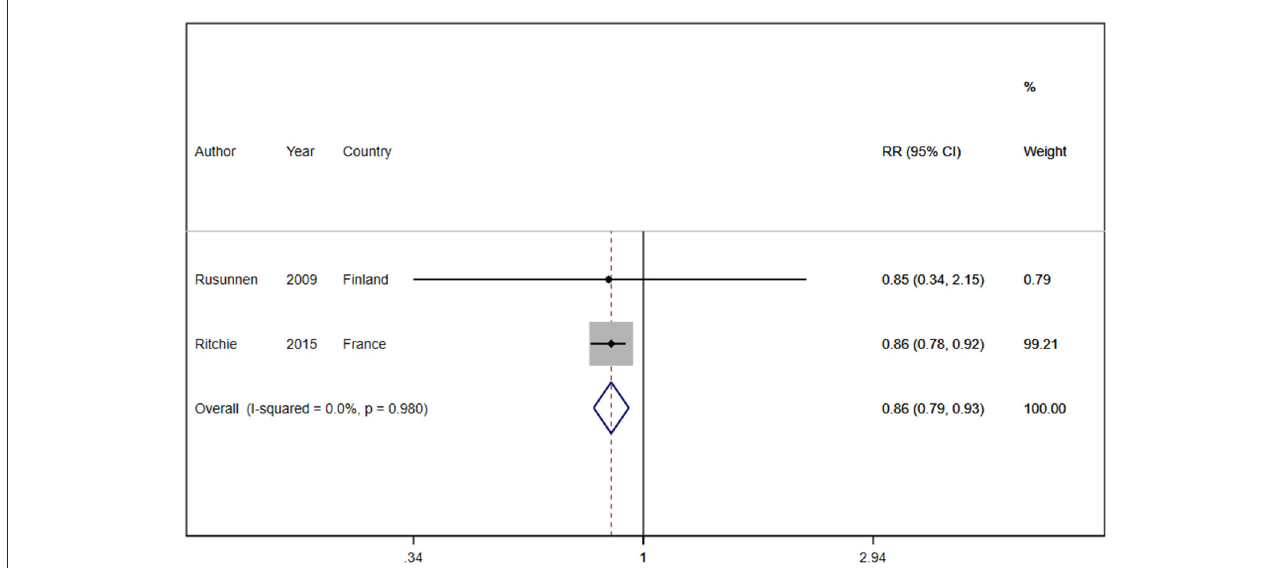
FIGURE5 Relative risk of depressive symptoms for the highest compared with the lowest category of caffeine intake. RR, relative risk.